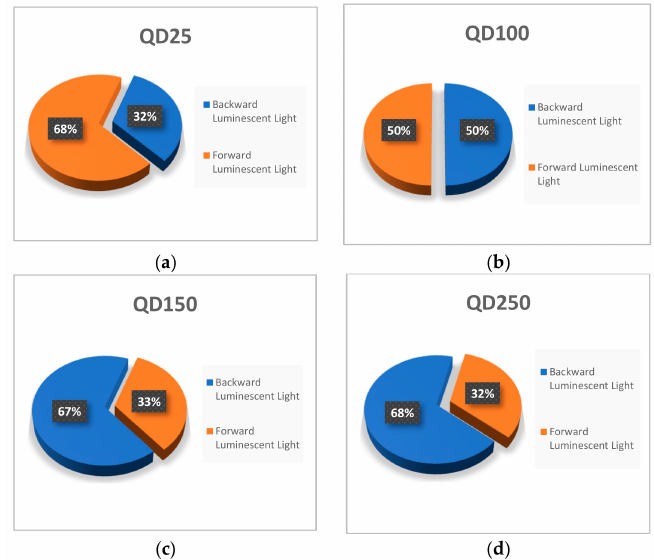
Figure 8. ( a ) The percentage of forward and backward luminescence light for the compound film with a QD concentration of QD25; ( b ) the percentage of forward and backward luminescence light for the compound film with a QD concentration of QD100; ( c ) the percentage of forward and backward luminescence light for the compound film with a QD concentration of QD150; and ( d ) the percentage of forward and backward luminescence light for the compound film with a QD concentration of